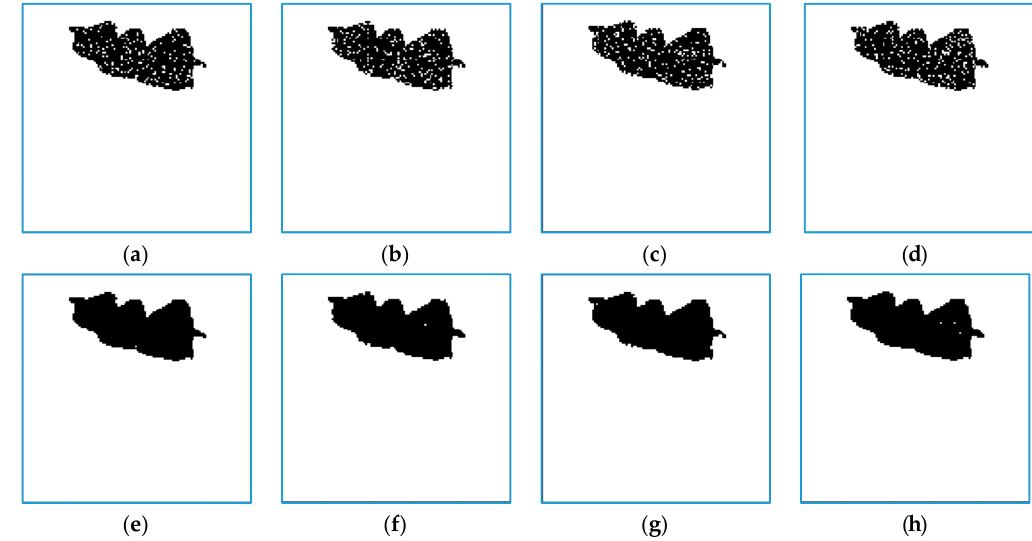
Figure 9. The 1st and 2nd detection results of different methods. ( a ) 1st stage, [17]; ( b ) 1st stage, [18]; ( c ) 1st stage, [19]; Figure 9. The st 1 and nd 2 detection results of different methods. ( a ) st 1 stage, [17]; ( b ) st 1 stage, ( d ) 1st stage, proposed method; ( e ) 2nd stage, [17]; ( f ) 2nd stage, [18]; ( g ) 2nd stage, [19]; ( h ) 2nd stage, proposed [18]; ( c ) st 1 stage, [19]; ( d ) st 1 stage, proposed method; ( e ) nd 2 stage, [17]; ( f ) nd 2 stage, [18]; ( g ) nd 2 stage, [19]; ( h ) nd 2 stage, proposed method.